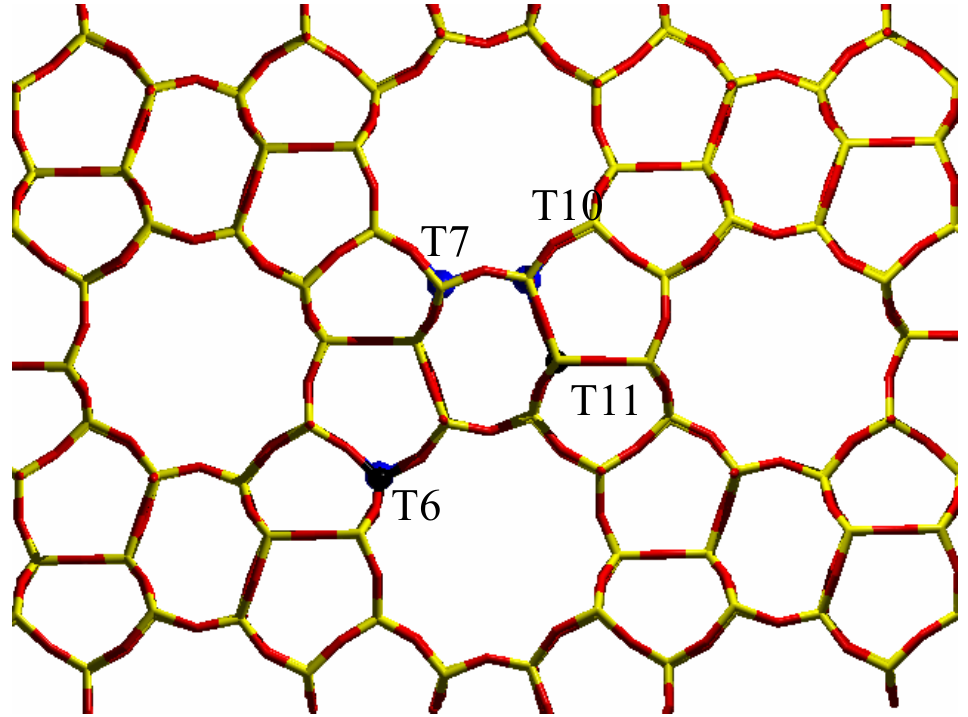
Figure 4: Stick representation of the MFI orthorhombic structure, viewed along the [010] direction: T sites and oxygen atoms have been represented by yellow and red sticks respectively. The preferen- tially substituted T6, T7, T10 and T11 sites have been evidenced by big blue spheres.